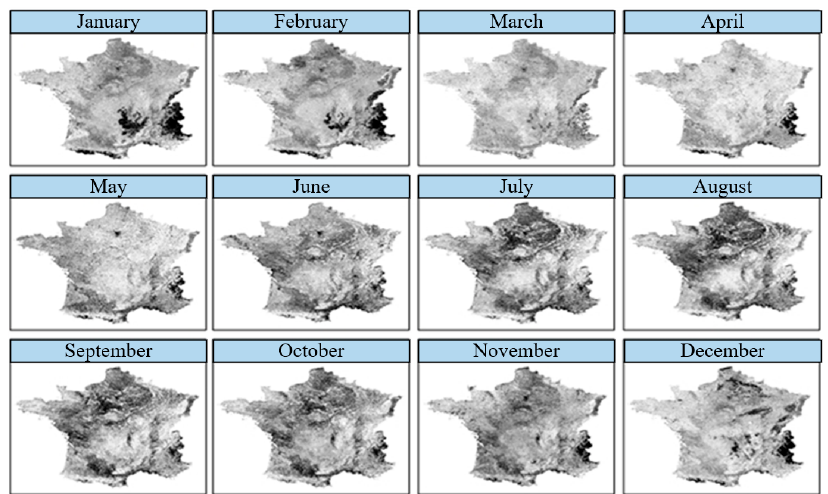
Figure 2. Preprocessed remote sensing data.